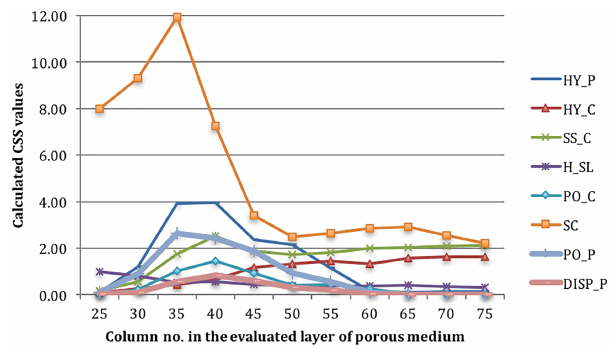
Figure 5. The CSS (composite scaled sensitivity) values of selected parameters at different locations along the conduit layer (from col- umn no. 25 to column no. 75) in the local sensitivity analysis.